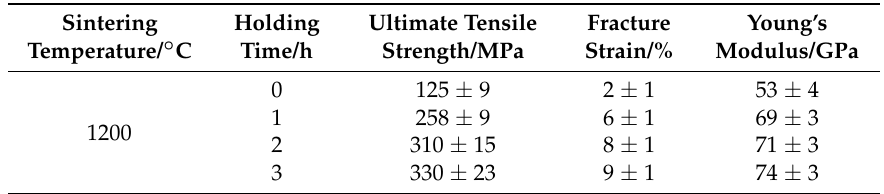
Table 2. Average static tensile properties of Fe-Mn-Si alloys sintered at 1200 ◦ C for different isothermal holding